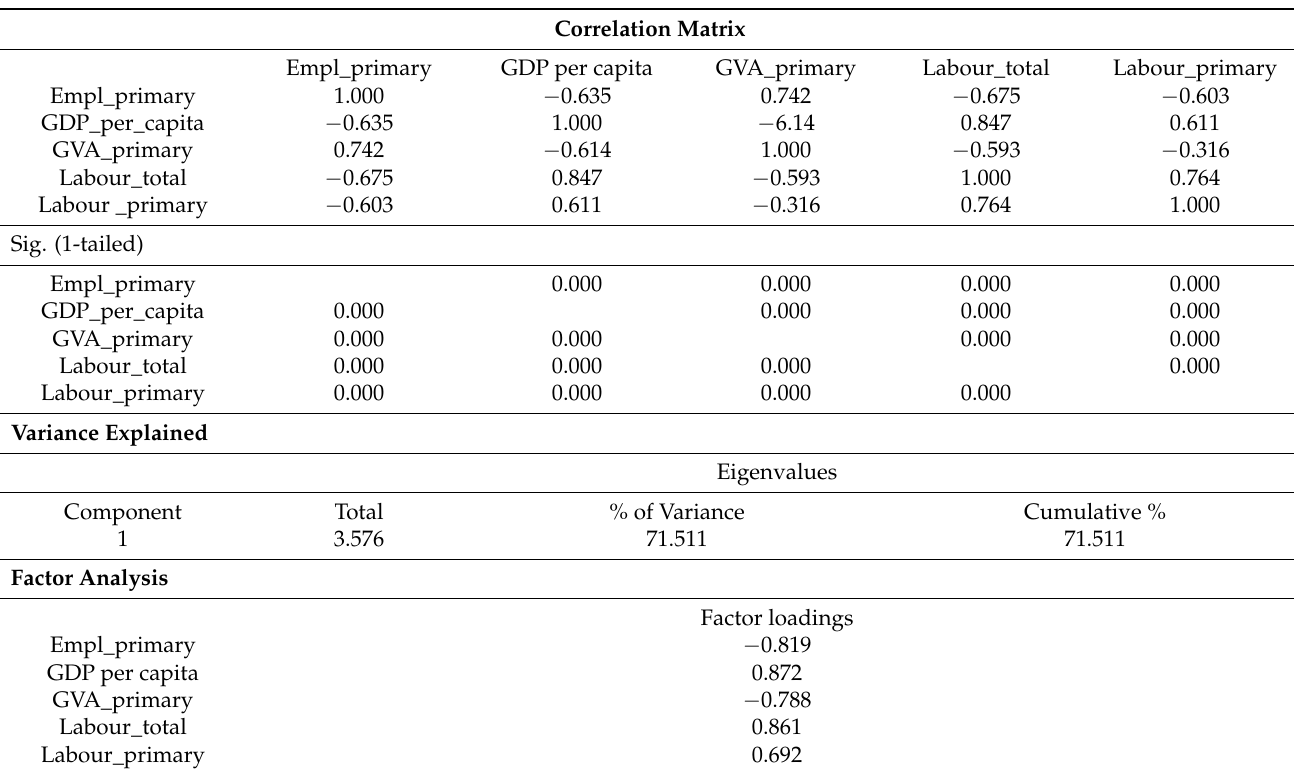
Table 2. Results of Factor Analysis: Socioeconomic performance of intermediate and predominantly rural regions. Correlation Matrix